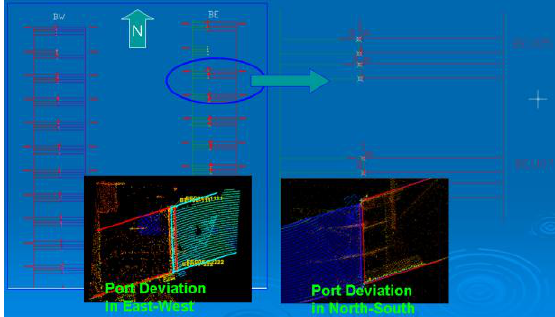
Figure14 the deviation of a single row